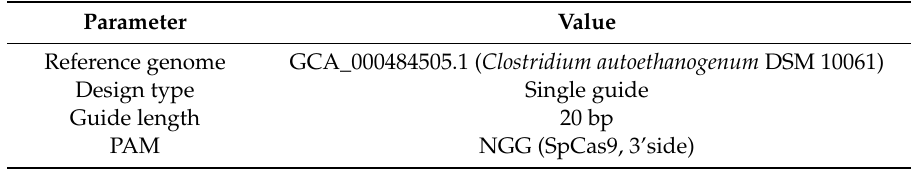
Table 2. Parameters used to calculate the o ff -target e ffi ciency (specificity score) of all nine bookmarks using the Molecular biology suite software suite of Benchling and the algorithm of Hsu et al.